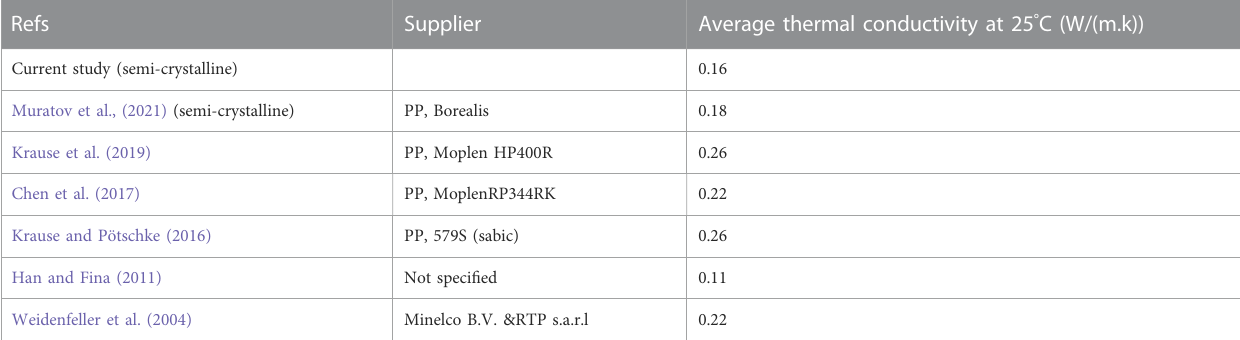
TABLE 5 Comparison of the thermal conductivity values obtained for the neat PP. It should be noted that the type of PPs in terms of its amorphous or semicrystalline structure was not addressed by the